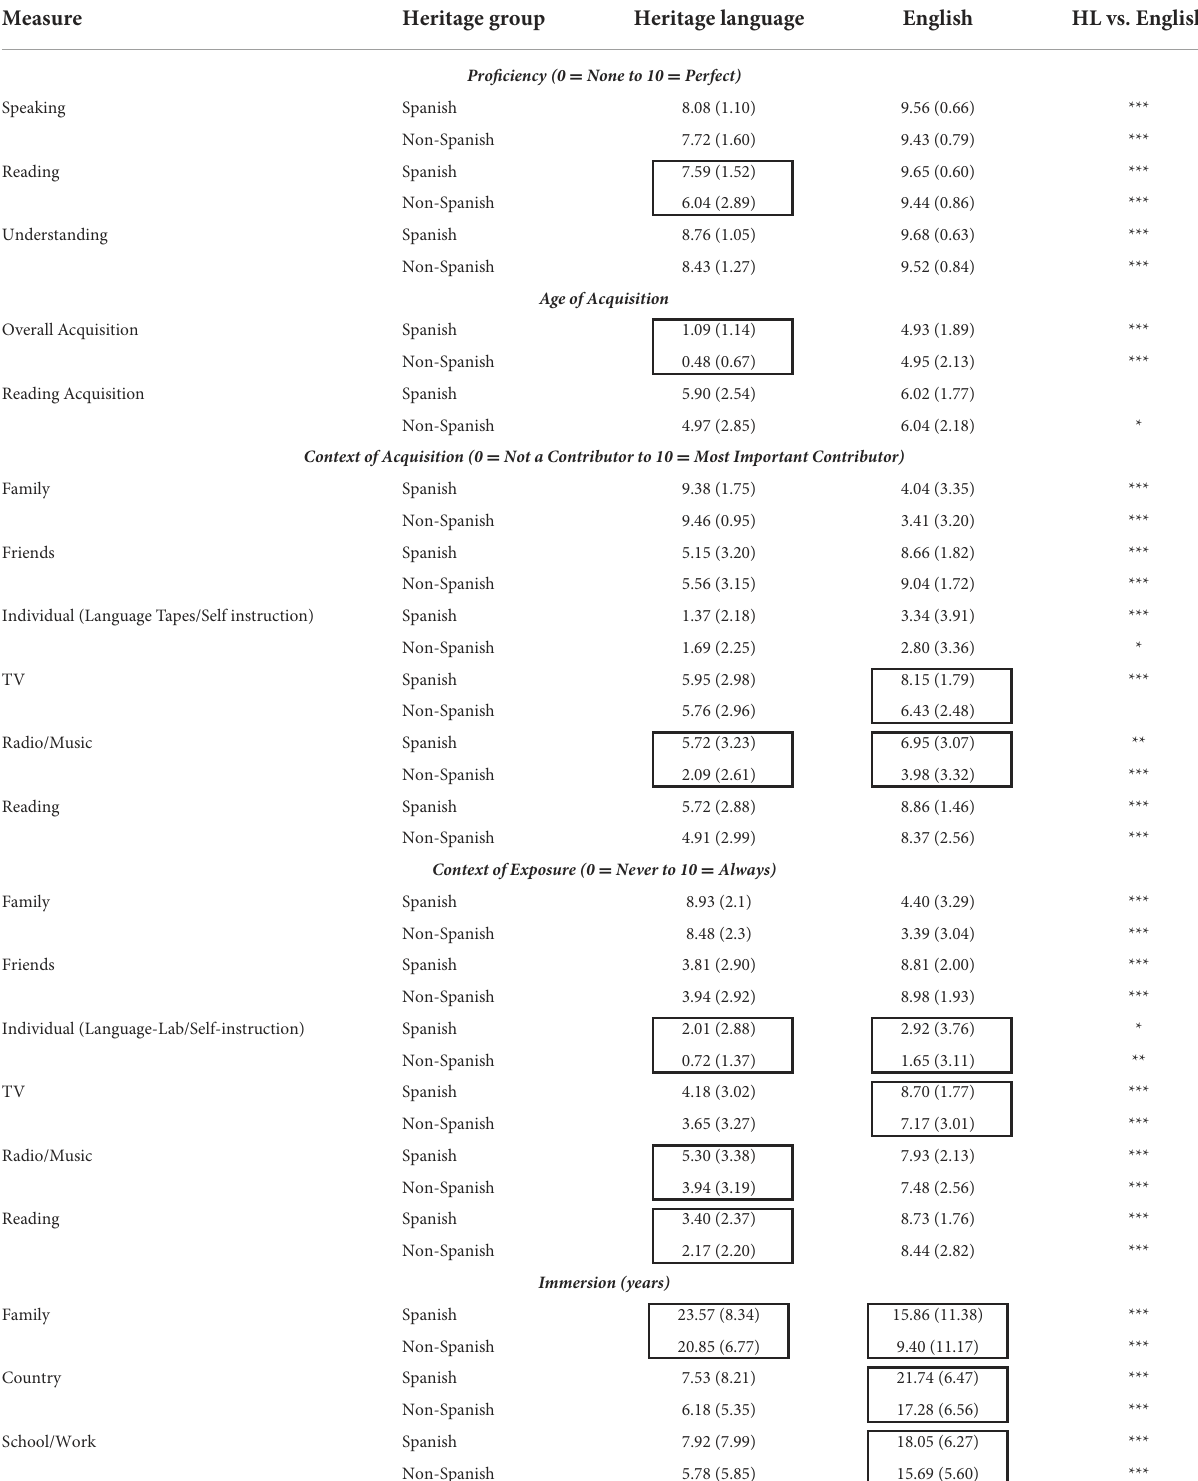
TABLE 1 Linguistic profiles of Spanish and non-Spanish heritage